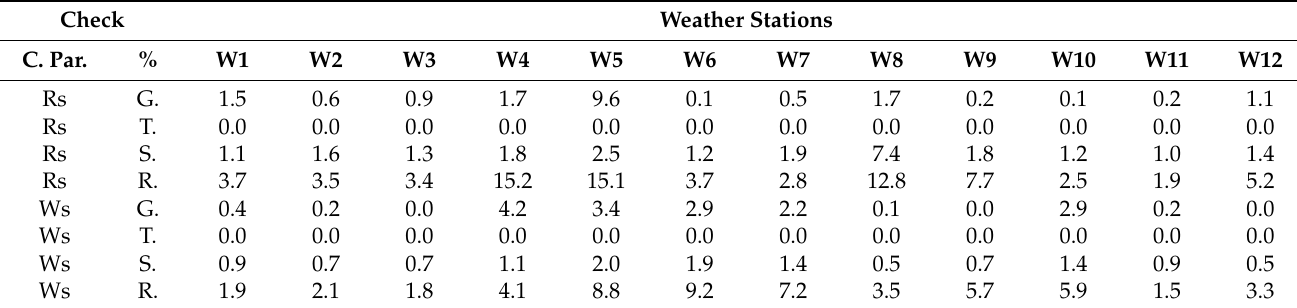
Table 3. Differences in the annual average from 2010 to 2017 of the solar radiation values measured by pyranometers (Rs-measured W. Station) and those measured by the satellite HELIOTSAT-SARAH (Rs-measured SARAH). Daily Weather Stations Average